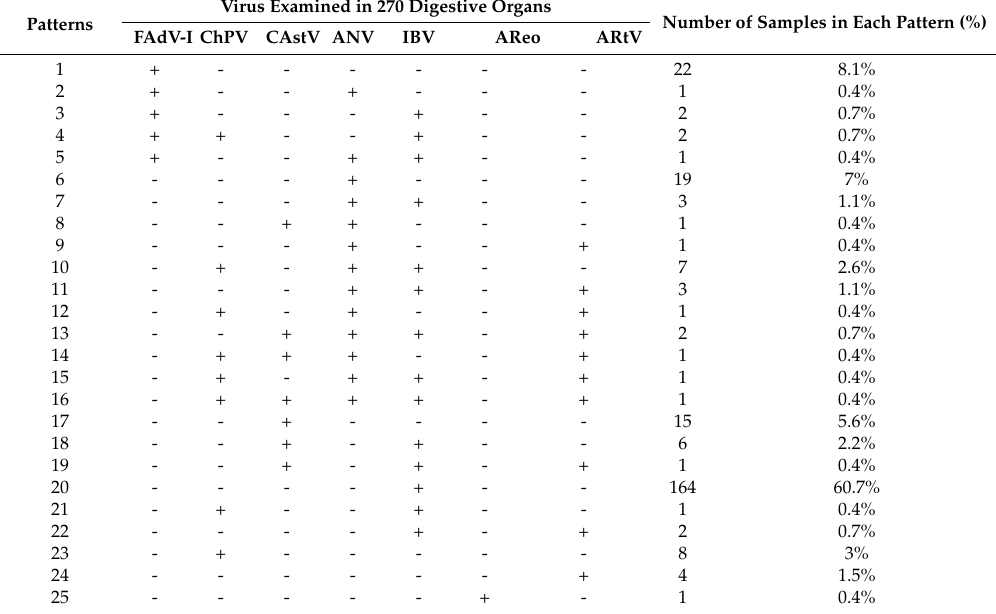
Table 3. Enteric virus detection patterns from 270 samples in different types of organs from chicken commercial flocks.